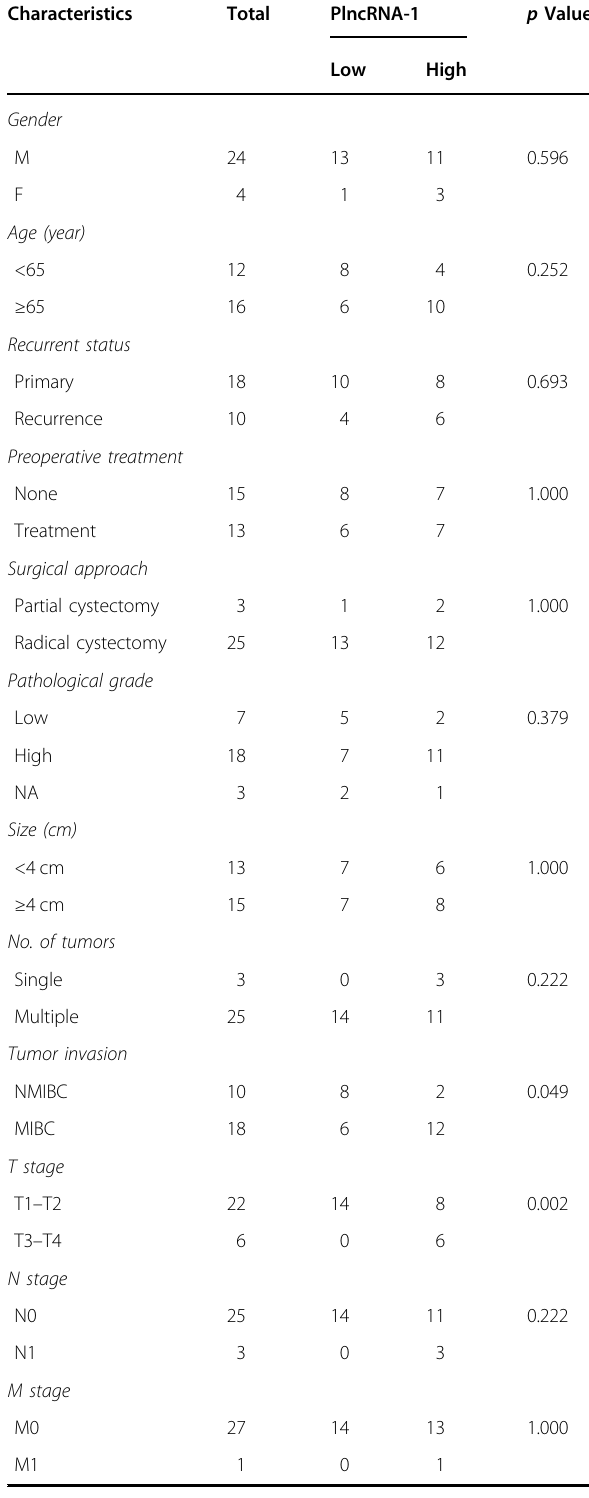
Table 1 The correlation between the expression levels of PlncRNA-1 and clinicopathological features of BC patients.